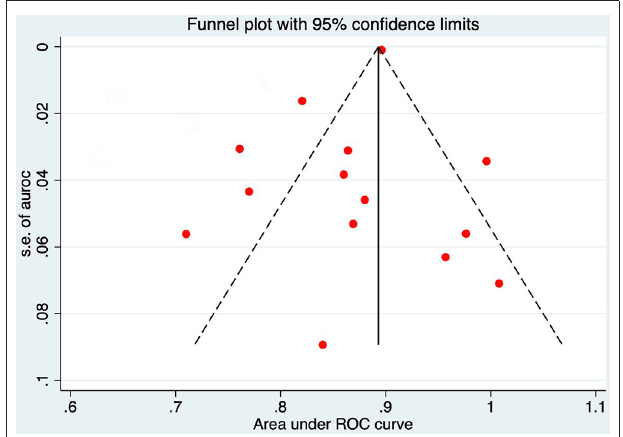
FIGURE 4 | Funnel plot of the area under the receiver operating characteristic in 14 studies.